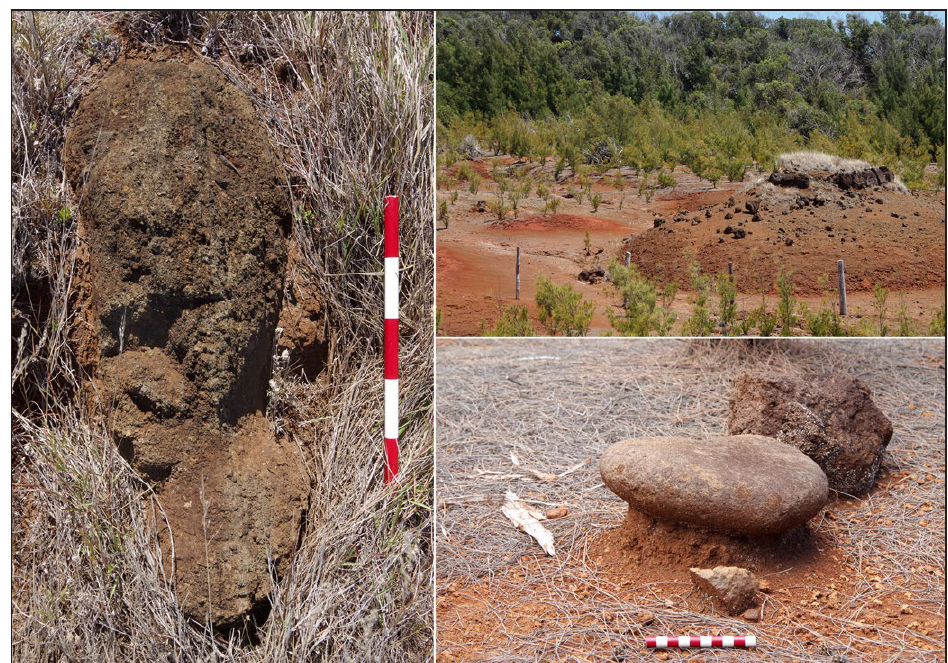
Figure 4: Erosion on Poike. Left: a small, heavily weathered moai to the rear of Ahu Hati Te Kohe. (The head of the moai is to the bottom of the picture). Top right: deep gully and sheet erosion around Ahu Viri Viri o Tumu in 2016. La Niña in the summer of 2016–17 was ‘the tipping point’ for its rear wall, which has now lost more stones. The trees ( Casuarina ) in the foreground and to the front of the ahu were planted in an attempt to inhibit further erosion. The trees in the background are Eucalyptus which here surround the eroded area. Bottom right: out of situ cultural stones pedestaled by ongoing sheet erosion. Photos: Mike Seager